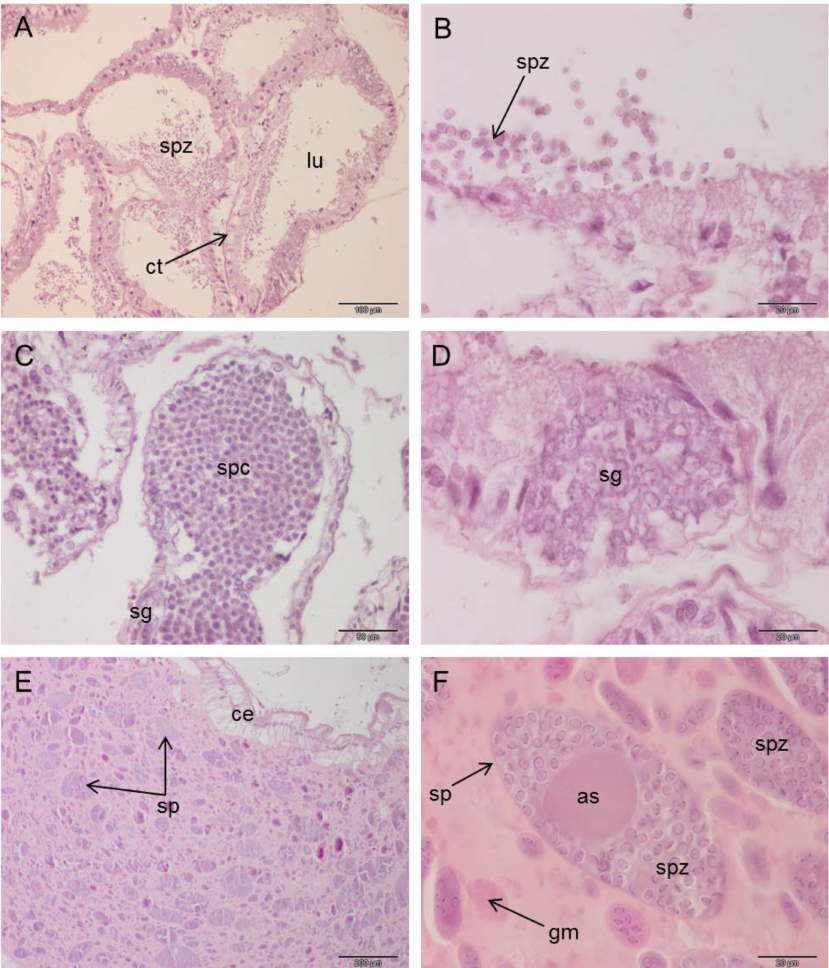
Figure 6. Histological cross sections of male Calappa granulata reproductive system: ( A ) developed testes showing seminiferous tubules surrounded by layer of connective tissue (ct) and with lumen (lu) containing few residual spermatozoa (spz); ( B ) detail of spermatozoa (spz) from the lumen of the seminiferous tubule; ( C ) seminiferous tubules with large clusters of spermatocytes (spc) and small cluster of spermatogonia (sg); ( D ) cluster of spermatogonia (sg) in the wall of seminiferous tissue; ( E ) section of anterior vas deferens with numerous spermatophores (sp) and membrane with columnar epithelium (ce) beneath the thin layer of connective tissue; ( F ) detail of spermatophore (sp) filled with spermatozoa (spz) and agranular substance